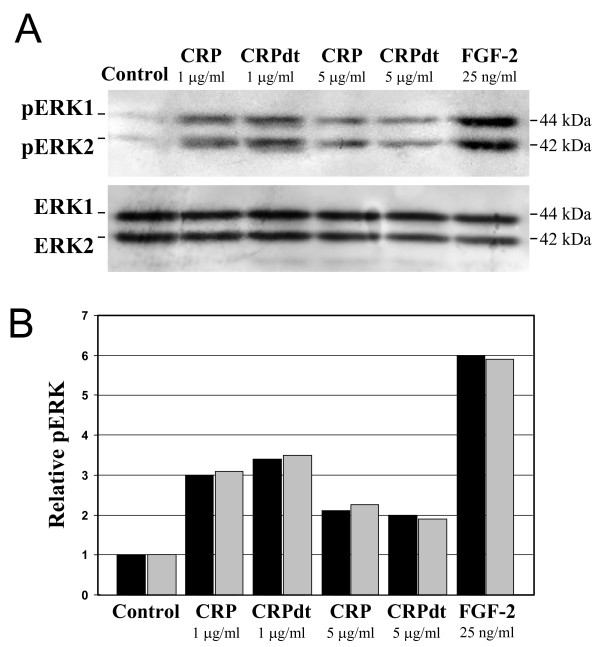
CRP activated ERK1/2 in HCAEC. A, Western blot showing the effect of 1–5 μg/ml CRP (non-detoxified and detoxified CRP [CRPdt]) on phosphorylation of ERK1/2 (pERK1/2) in HCAEC. The increase was similar to that produced by FGF-2 (25 ng/ml). Total ERK1/2 protein levels were used as a loading control. Experiments were performed at least twice and a representative example is shown. B, quantitative densitometic analysis of the blot shown in A. (ERK-1 [black bars]; ERK-2 [shaded bars]).